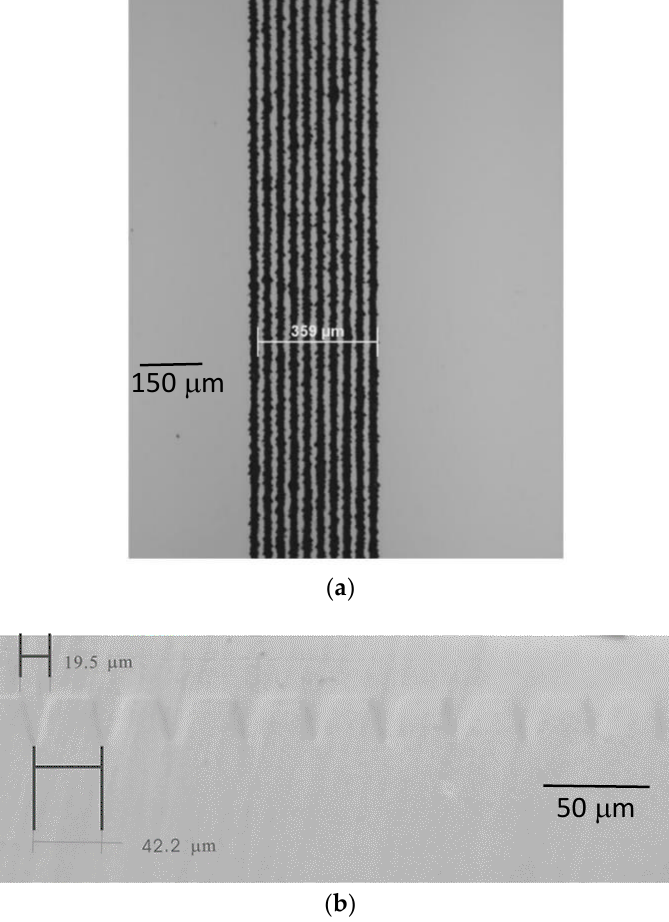
Figure 9. ( a ) Top view of machined lithium niobate substrate. Scale bar of 150 µ m is shown. ( b ) Di ff erential interference microscopic image of the polished end face of as-grown lithium niobate channel waveguides after liquid phase epitaxial thin film growth. Scale bar of 50 µ m is shown.